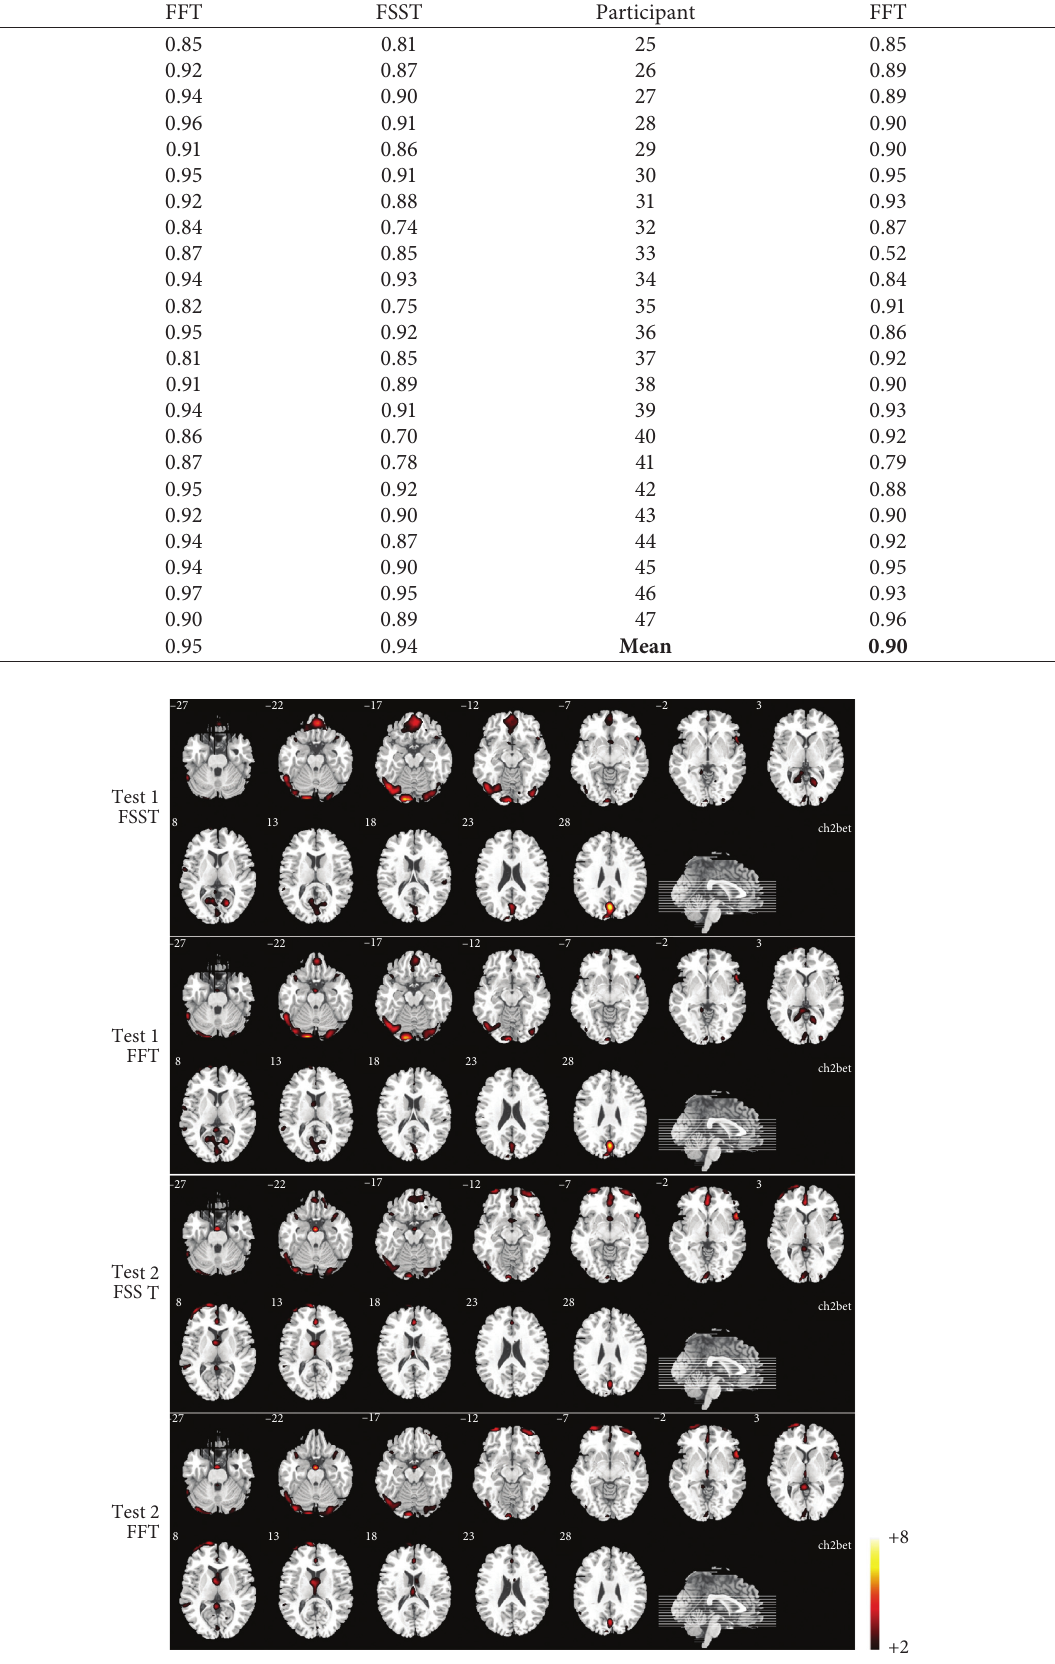
Figure 1: Analysis results of 2 groups of data from participant 33 using FSST and FFT